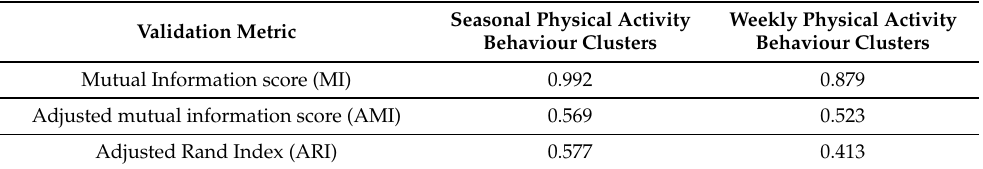
Table 2. Model evaluation metrics for yearlong physical activity step behaviours.